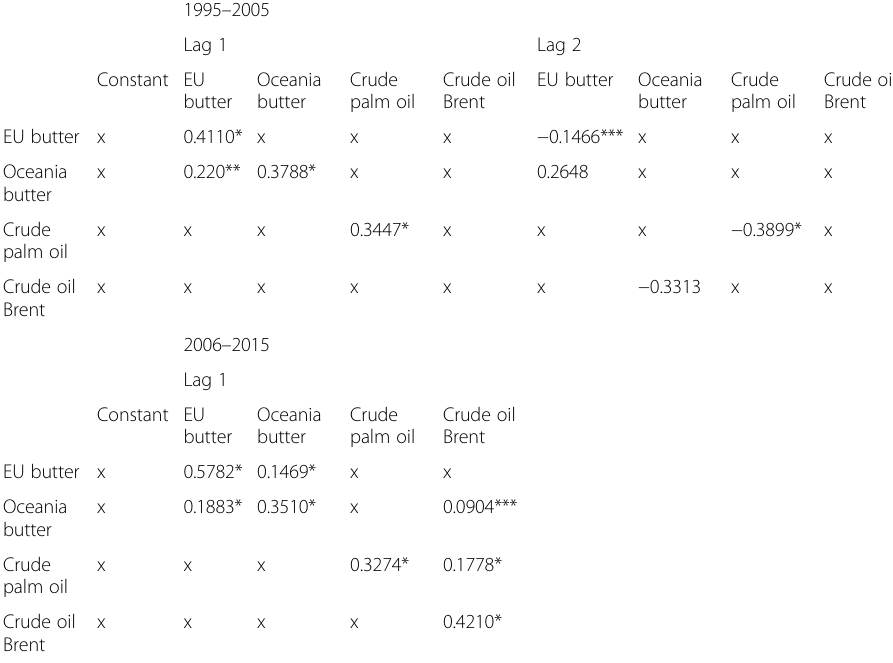
Table 4 Coefficients of the VAR processes for the first period (1995 to 2005) and second